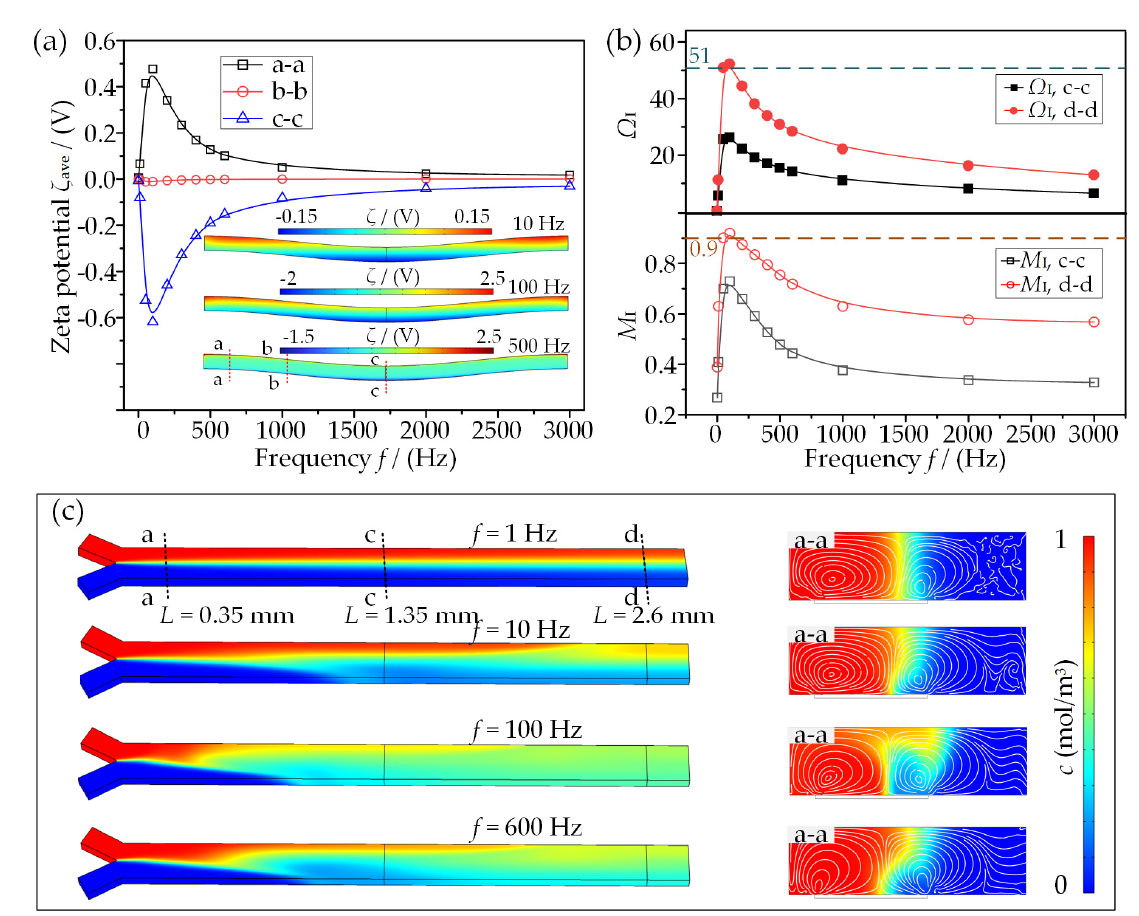
Figure 7. Influence of AC frequency f on the mixing performance: ( a ) variations of averaged zeta potential with f on three selected lines; ( b ) the mixing index and vortex index in terms of f ; ( c ) concentration distributions under different AC frequencies.